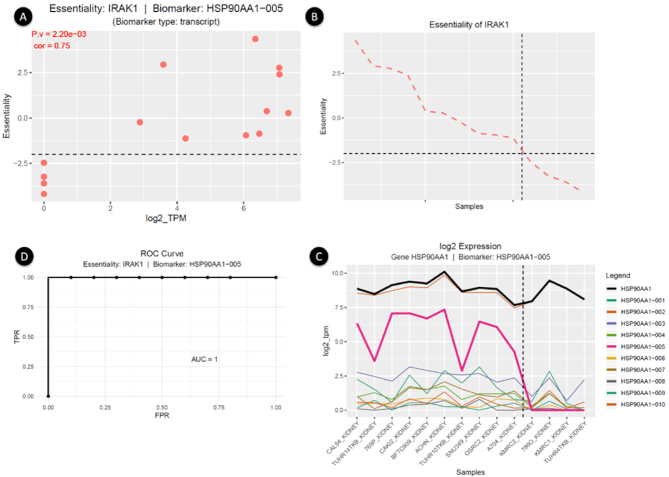
Output of TranscriptAchilles in renal carcinoma cell lines (n = 14). HSP90AA1-005 is a transcript biomarker of essentiality of IRAK1. (A) Scatterplot of IRAK1 essentiality and HSP90AA1-005 log2-expression. Each dot represents a single cell line. The dotted black line marks the –2 essentiality threshold. (B) Essentiality of IRAK1. Samples are sorted by their essentiality (more negative implies IRAK1 is more essential). Samples in panels B and C are sorted in the same order. The x-axes are shared by both panels. The black line marks the default essentiality score of –2 dividing the samples into resistant and sensitive to IRAK1 KD. (C) log2-expression of gene HSP90AA1 (black line) and its transcripts. The dotted black line divides cell lines into resistant (left side) and sensitive (right side). The best biomarker (HSP90AA1-005) is shown in pink. In this case, transcript expression provides better essentiality markers than gene expression. (D) Receiver operating characteristic (ROC) curve of the selected biomarker. Here the AUC is 1, but this is not generally the case.